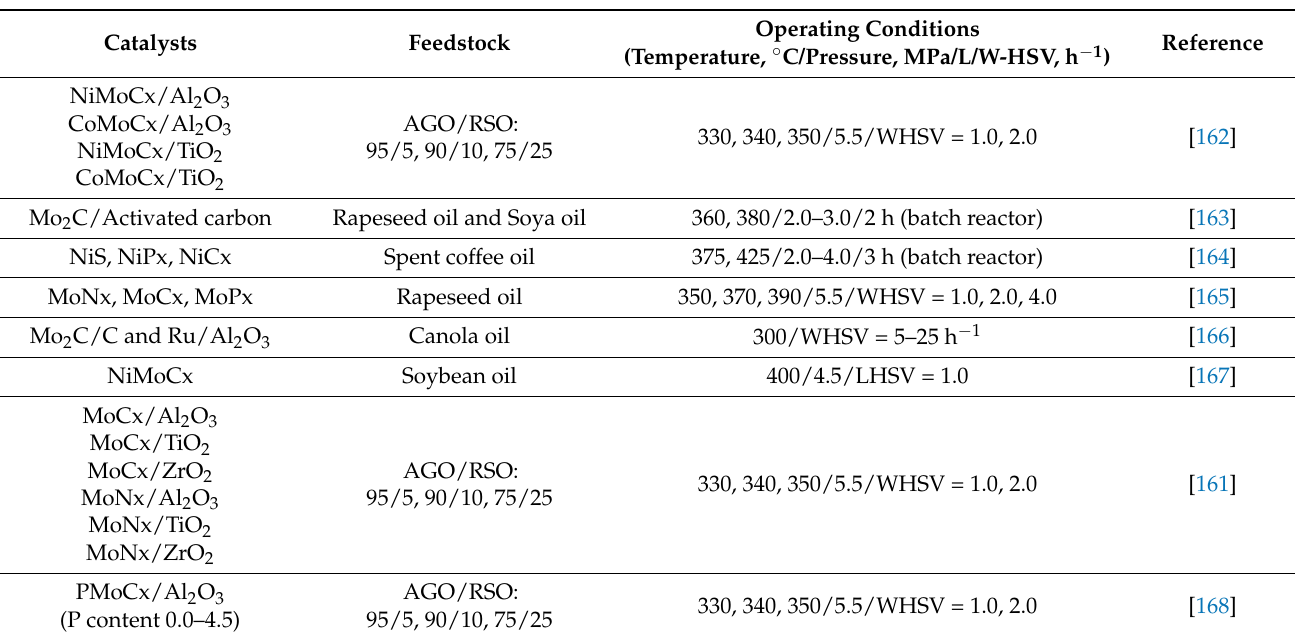
Table 7. List of Sulphur free carbide/nitride heterogeneous catalysts using for green diesel by vegetable oil hydrotreating or co-processing with petroleum feedstocks.